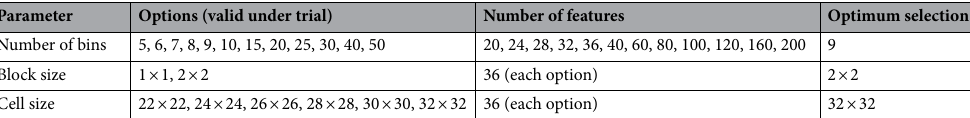
Table 11. Optimal parameters of HOG feature extraction module.